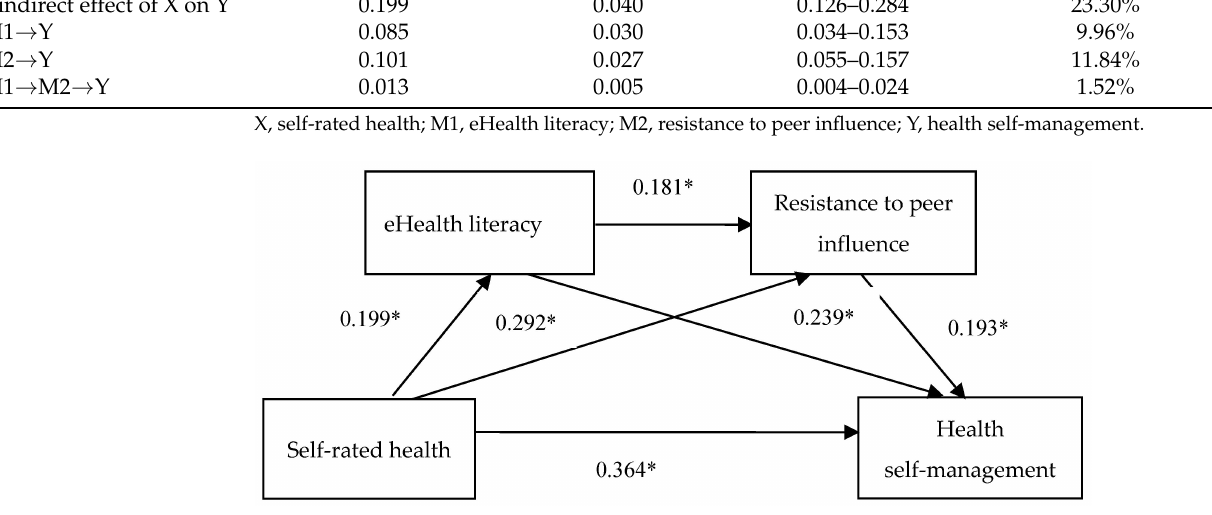
Figure 1. The double chain mediation model of eHealth literacy and resistance to peer influence as mediators of the effect of self-rated health on health self-management. * p <